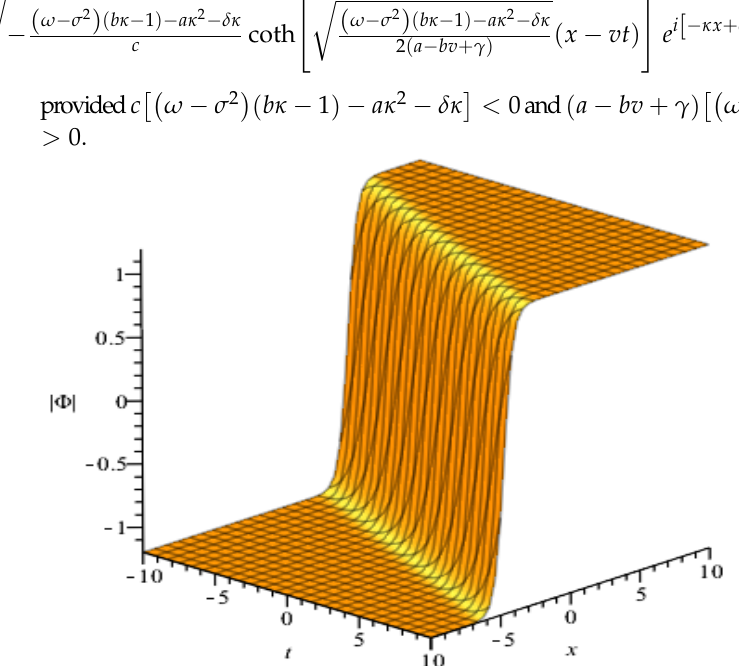
Figure 3. Plot of the dark soliton solution (24) with a = 0.2, b = 0.35, c = 0.4, δ = 0.5, κ = 0.25, ω = 0.6, σ = 0.35, v = − 0.4743835616, γ = − 0.5, and − 10 ≤ x , t ≤